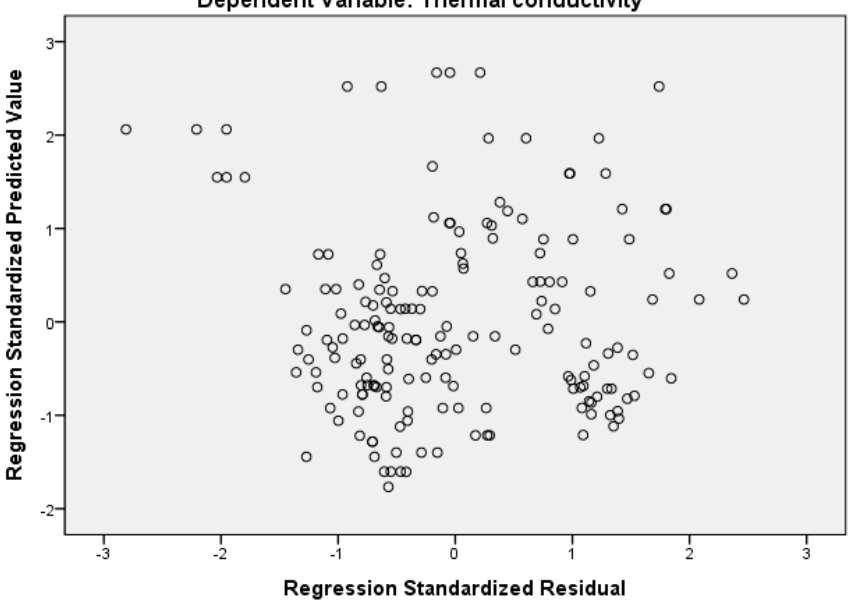
Figure 6. Homoscedasticity plot of residuals.